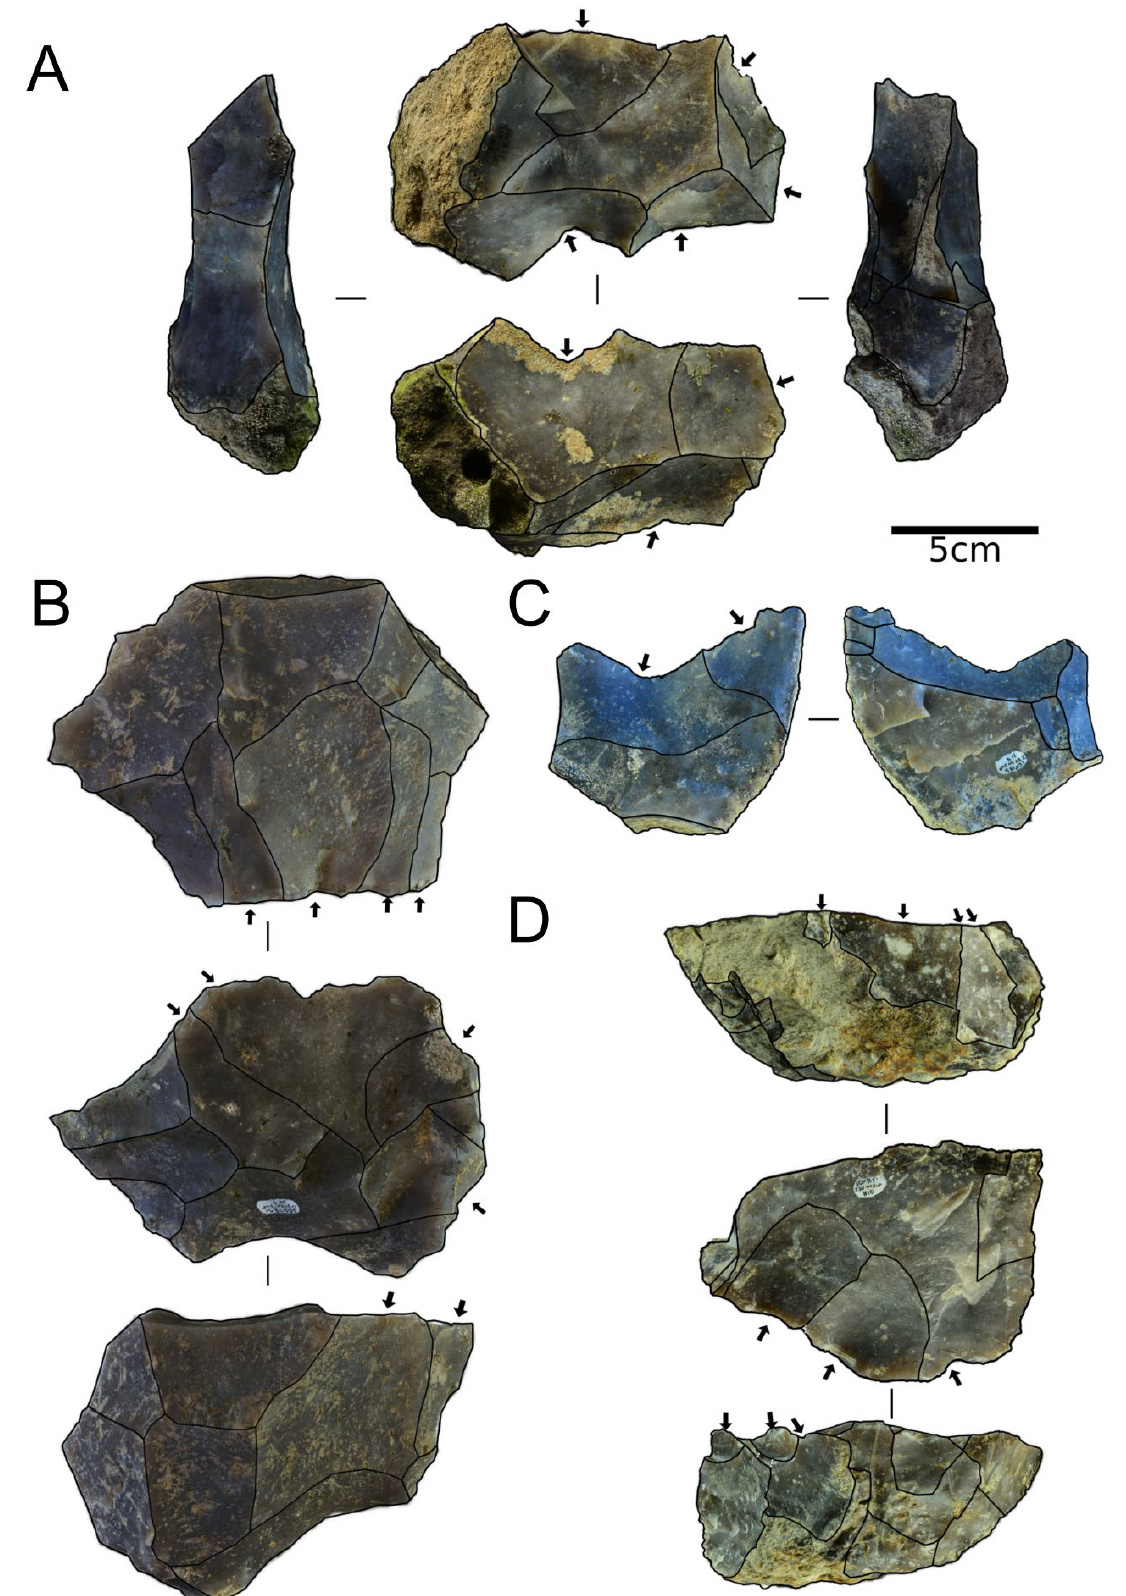
Figure 9. Some cores form LGN. A) Discoidal core LGN’18_sup_L20_2. B) Polyhedral core LGN’18_sup_D31_1. C) Core on flake LGN’18_sup_I30_4. D) Discoidal core LGN’18_J30_10 (Drawings and photographs by M.